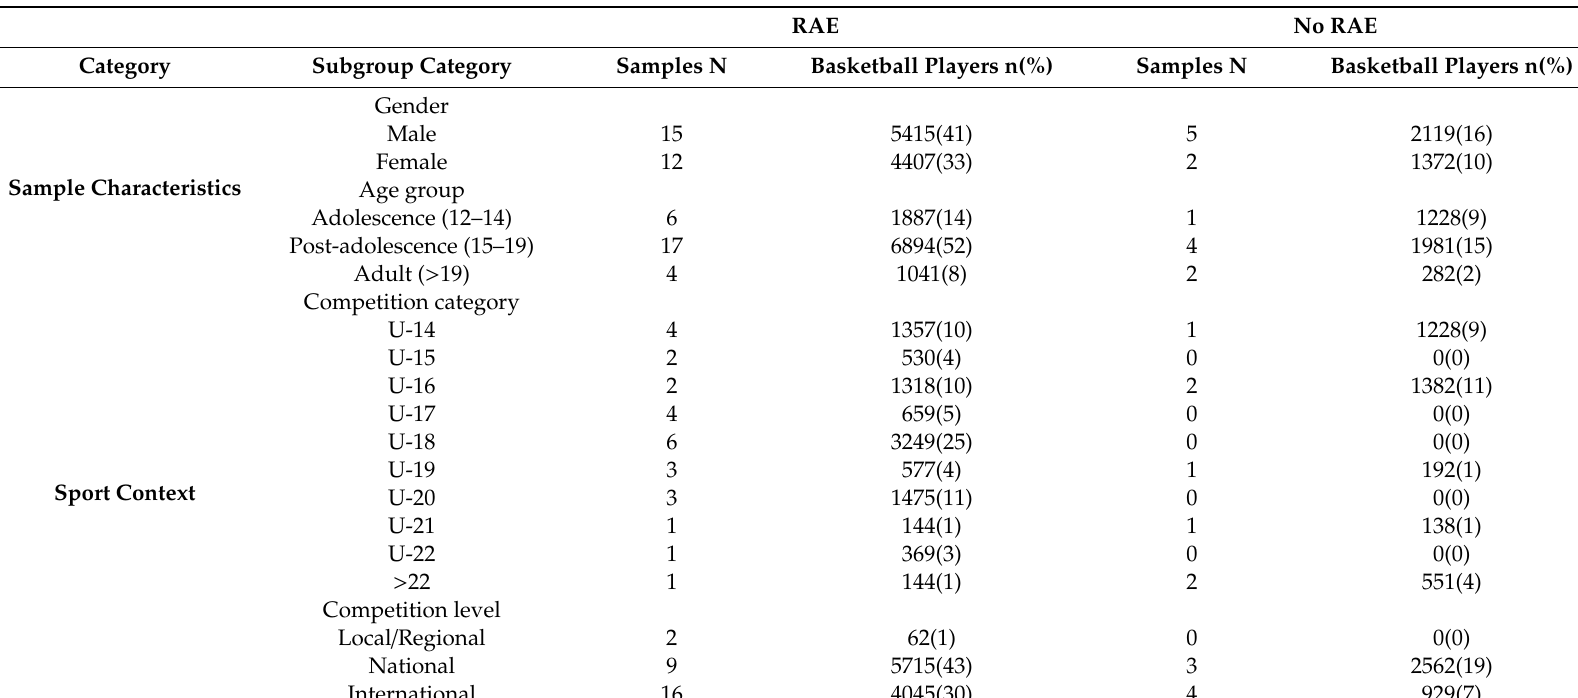
Table 2. Summary of sample’s distribution (n and %) according to the relative age e ff ect identified (RAE or No RAE) by characteristics of basketball players (gender and age group) and sport context (competition category and competition